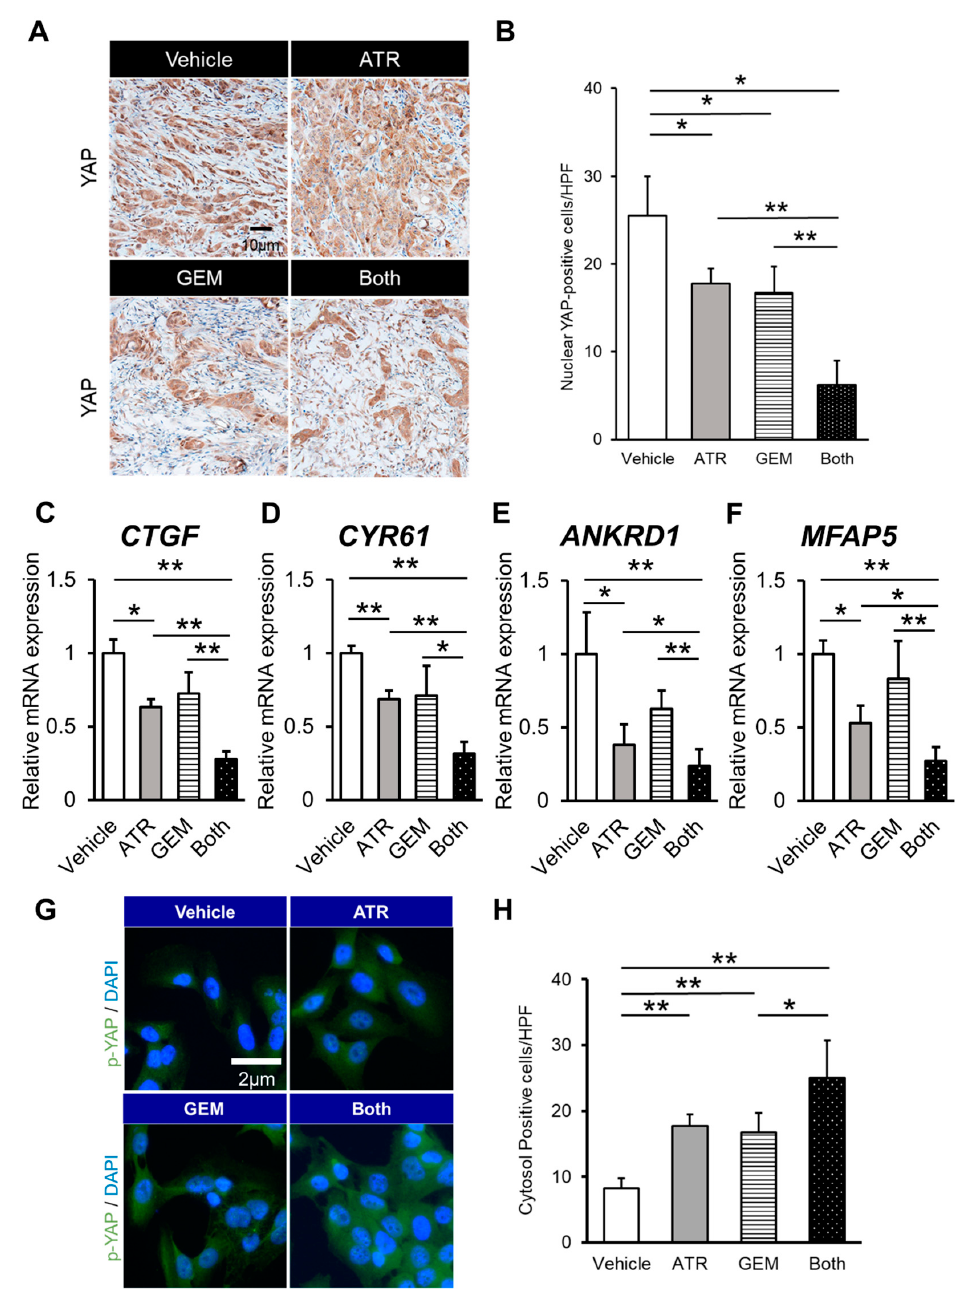
Figure 6. Gemcitabine plus atorvastatin interfered with Yes-associated protein (YAP) nuclear shuttling in HuCCT-1 cell-derived xenograft tumors. ( A ) Representative pictures of HuCCT-1 cell-grafted subcutaneous tumors stained for YAP. ( B ) Quantification of nuclear YAP-positive cells. The number of immunopositive cells in high-power fields was counted. ( C – F ) Relative mRNA expression of CTGF , CYR61 , ANKRD1 , and MFAP5 in HuCCT-1 cell-grafted subcutaneous tumor tissues. The mRNA expression levels were measured using quantitative real-time PCR, and glyceraldehyde-3-phosphate dehydrogenase was used as an internal control. Quantitative values are indicated as ratios relative to the values of the vehicle-treated group. ( G ) Representative pictures of HuCCT-1 cells immunofluorescently stained for phospholylated YAP. ( H ) The number of immunopositive cells in their cytosols in high-power fields was counted. ATR, atorvastatin-treated mice. GEM, gemcitabine-treated mice. Both, mice treated with both atorvastatin and gemcitabine. Data are presented as the mean ± SD ( n = 10). * p < 0.05; ** p <